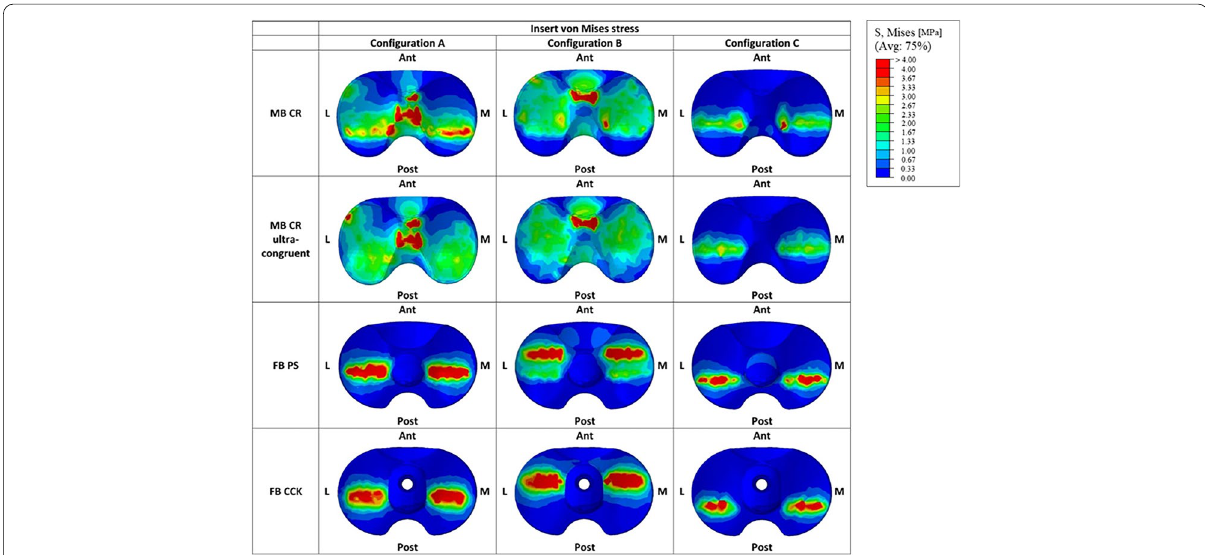
Fig. 9 Qualitative overview of the polyethylene von Mises stresses for all the considered models in the three studied configurations. (M lateral, Ant anterior, Post posterior) = = =